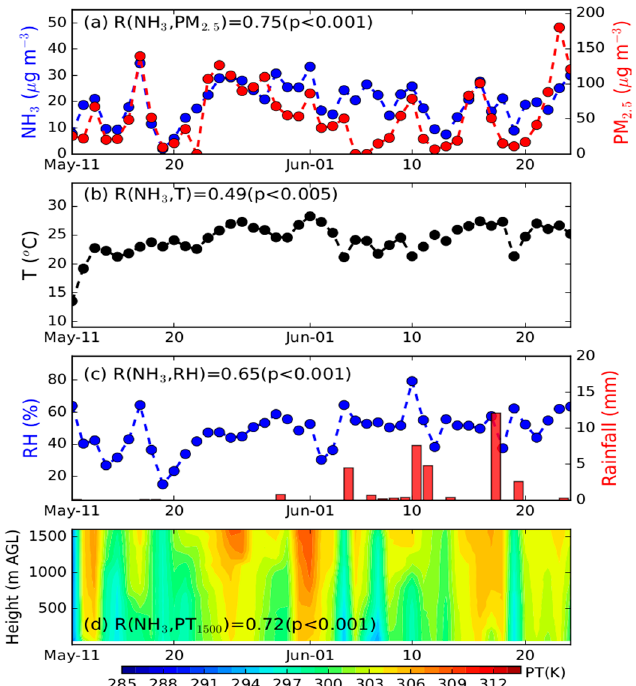
Figure 2. Daily variations in ( a ) NH 3 and PM 2.5 concentrations, ( b ) 2-m temperature (T), ( c ) 2-m relative humidity (RH), and rainfall, ( d ) potential temperature vertical profile in Beijing from 11 May to 24 June, 2015. There were in total 12 rainy days during the studied period, and the correlation coefficients (R) between the NH 3 concentration and different variables in Beijing under dry conditions are given for each panel, including the PM 2.5 concentration, T, RH and 1500-m PT.